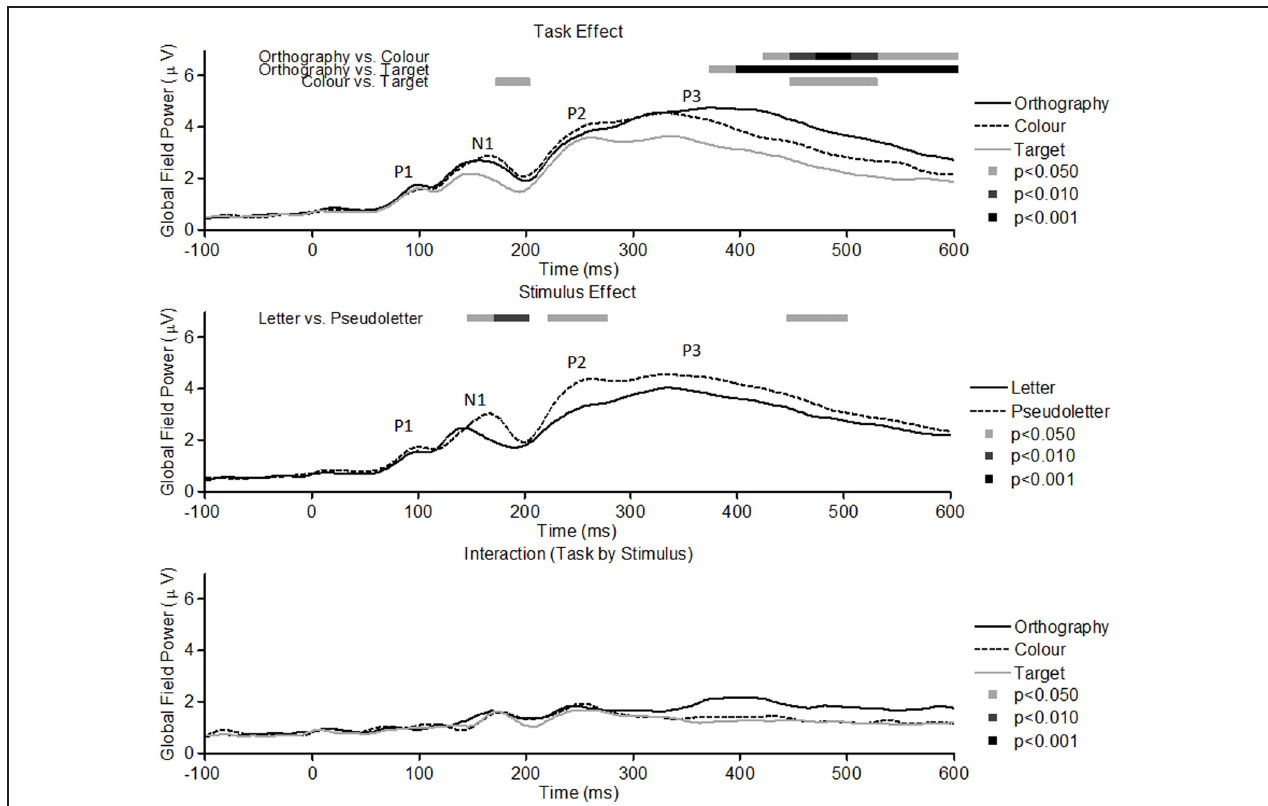
for the Interaction are plotted as the differences between letter and pseudoletters for each task (Orthography, Color, and Target). Peaks in the waveforms reflect P1, N1, P2, and P3 responses of the evoked potentials. Bars above the waveforms designate intervals of significant main effects at p < 0 . 05, p < 0 . 01, and p < 0 .